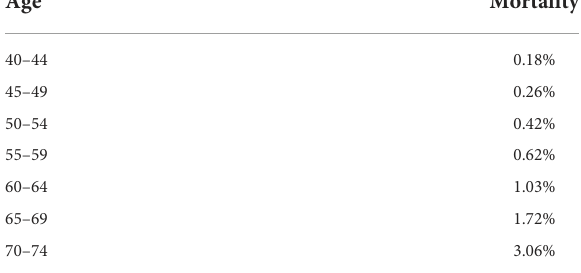
TABLE 1 Age-specific natural mortality